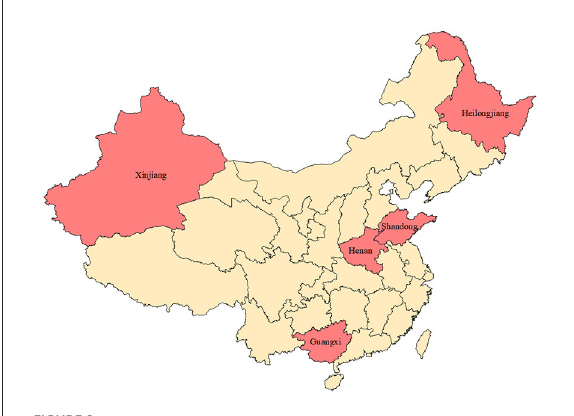
FIGURE2 Geographical location of major agricultural producing